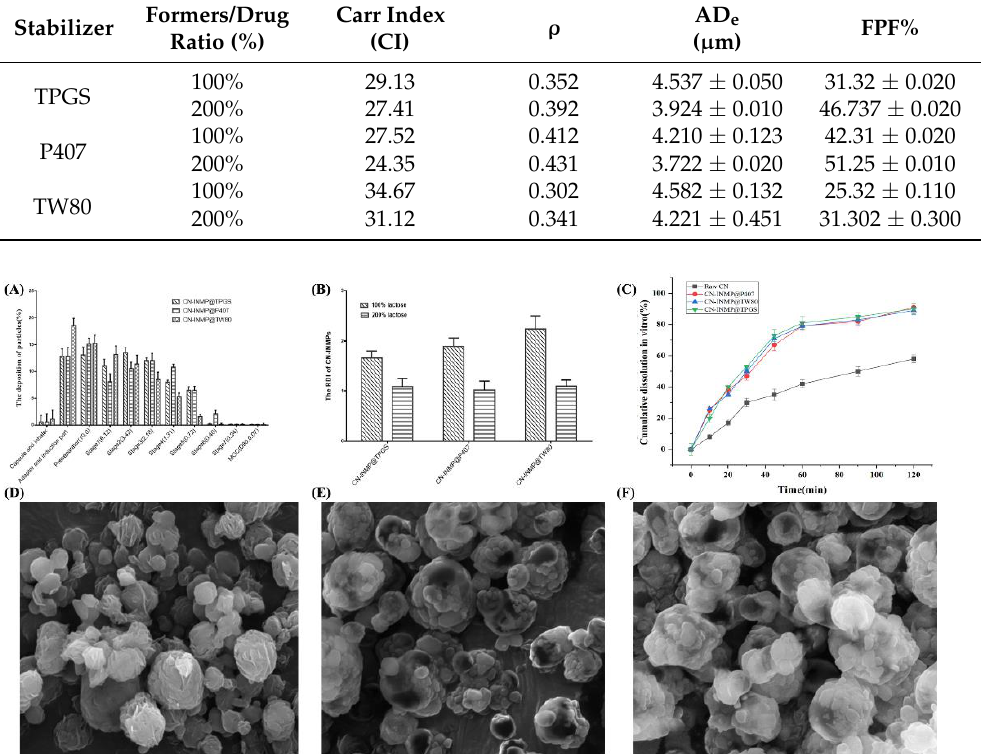
Table 1. The particle size and aerodynamic parameters of CN-INMPs (x ± s, n = 3). Stabilizer